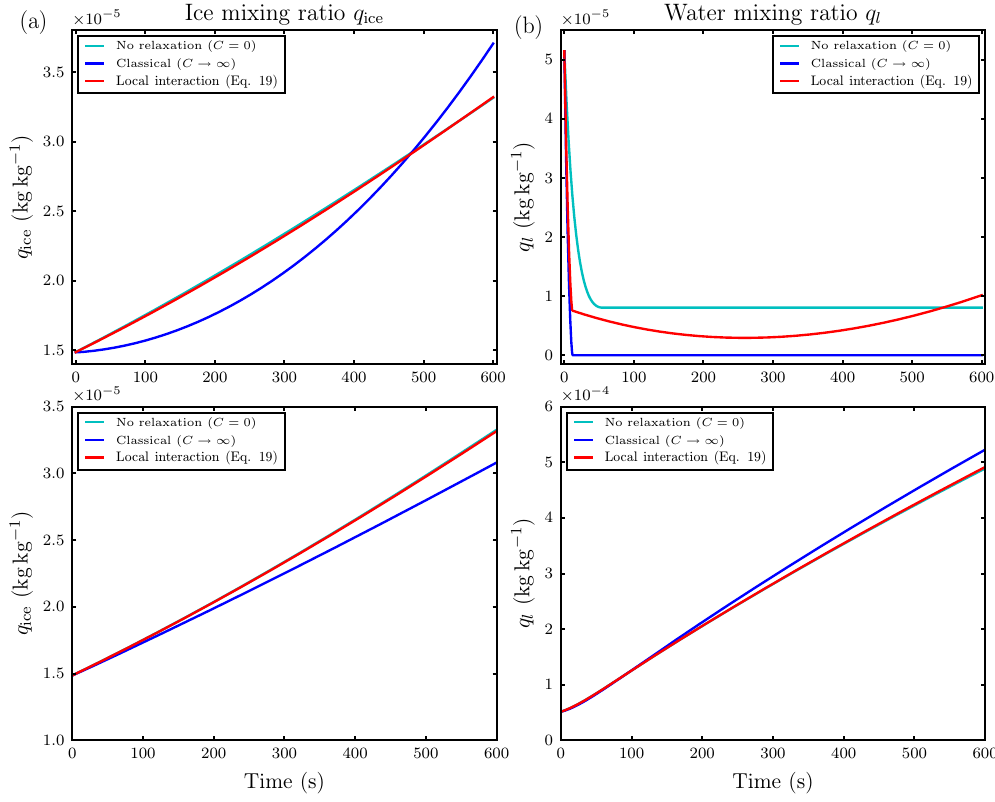
Figure 9. Temporal evolution of the ice mixing ratio (a) and liquid water mixing ratio (b) for the parcel model simulation with w = 1 , ms − 1 and N d = 500 droplets in each influence sphere of the ice crystals and droplet distance l 0 = 5 R i . The upper row is at ambient saturation ratio S ∞ = 0 . 847 and the lower row is at S ∞ = 1 . 01. Note the different scaling of the axes.